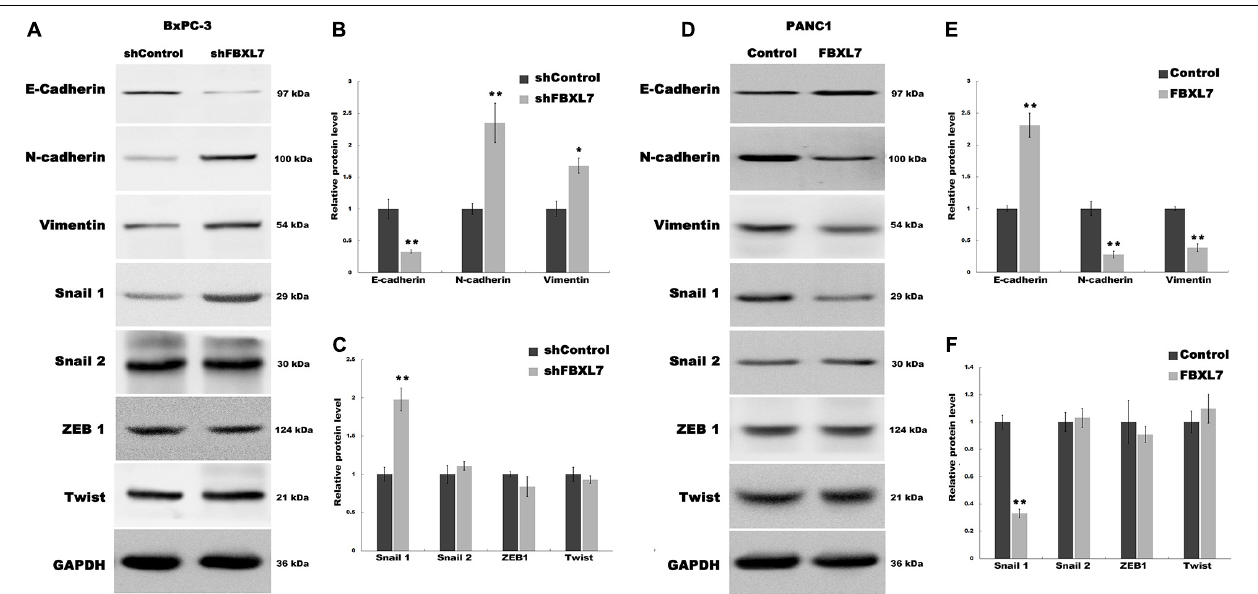
FIGURE 4 | FBXL7 regulates the EMT process of PCa. (A–C) The expression of E-cadherin, N-cadherin, Vimentin, Snail1, Snail2, ZEB1 and Twist protein was detected by Western blot analysis in BxPC-3 cells after shFBXL7 transfection. (D–F) The expression of E-cadherin, N-cadherin, Vimentin, Snail1, Snail2, ZEB1 and Twist protein was detected by Western blot analysis in PANC1 cells after FBXL7 overexpression. Data represent means ± SD of three independent experiments with significance determined by two-tailed Student’s t -test * P < 0.05, ** P <